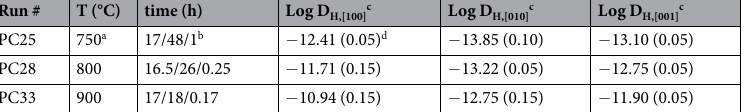
Table 1. H self-diffusion coefficients in olivine at 2 GPa. a Temperature of the wet and exchange experiments 30 ; b durations of dry/wet/exchange experiments 30 ; c D in m 2 /s; d value in parentheses is 1 standard deviation (see Figure